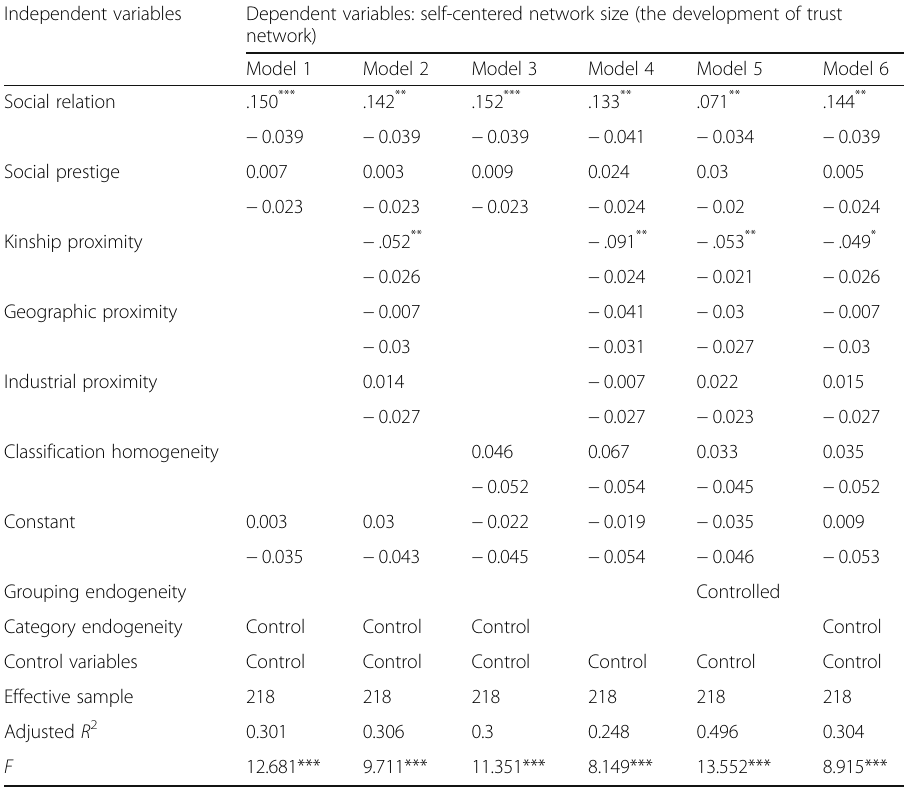
Table 4 Regression results of individual social capital and the development of a trust network Independent